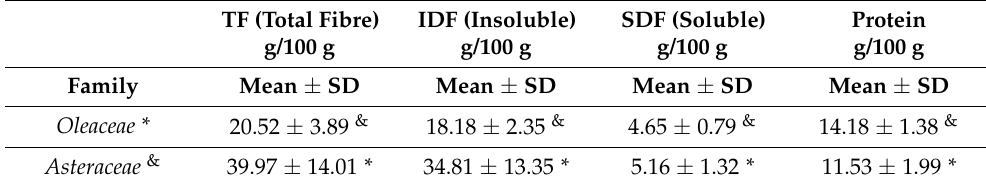
Table 3. The content of dietary fibre (total, soluble and insoluble fractions) and total protein in Oleaceae and Asteraceae family.